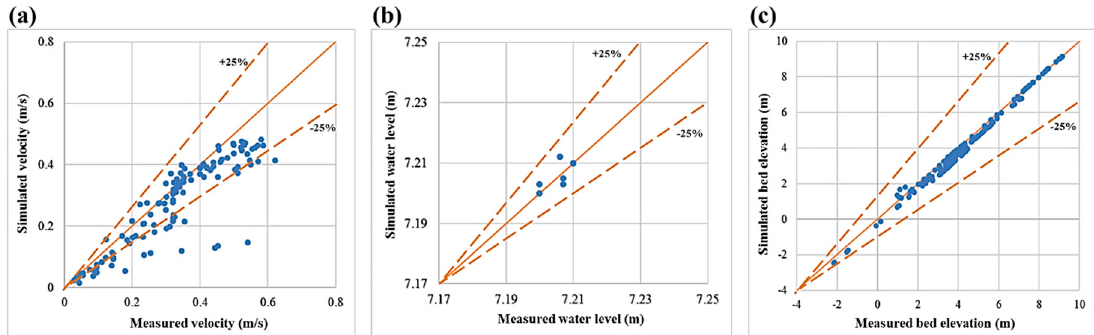
Figure 10. Comparison between measured and simulated data used in the model calibration ( a ) Figure10. Comparisonbetweenmeasuredandsimulateddatausedinthemodelcalibration( a )averaged averaged velocity; ( b ) water level; ( c ) bed elevation. velocity; ( b ) water level; ( c ) bed elevation. Table 3. Statistical indices for measured and simulated average velocities.